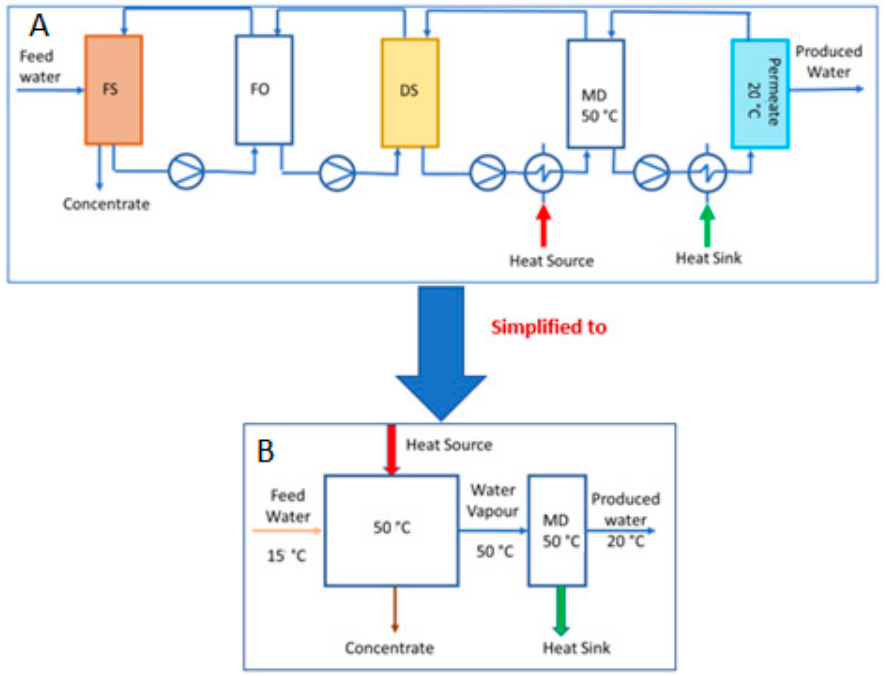
Figure 2. An integrated FO-MD process for wastewater treatment and water production with exter- nal heat source and heat sink: ( A ) detailed and ( B ) simplified process flow diagram. heat source and heat sink: ( A ) detailed and ( B ) simplified process flow